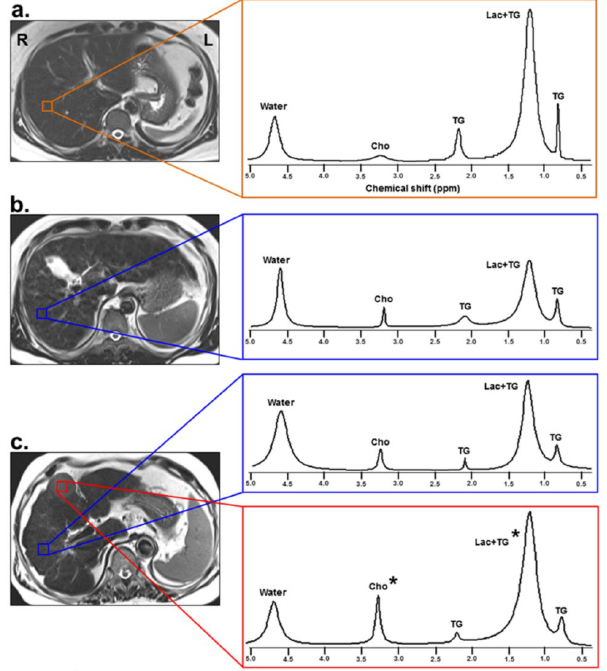
Figure 1. An axial plane anatomic image with spectroscopy voxel localized in the right lobe of the liver (left) and representative 1 H MR spectra (right) from NC (a), LC patient without HCC (b), and LC patient with HCC (c). The voxel is targeted to the normal liver (brown), cirrhotic liver (blue), and HCC (red). The asterisk (*) indicates a significant di ff erence in the metabolic concentration ratios among the groups ( p < 0.05). R, right; L, left; NC, normal control; LC, liver cirrhosis; HCC, hepatocellular carcinoma; Lac + TG, lactate + triglyceride; Cho, choline; TG,